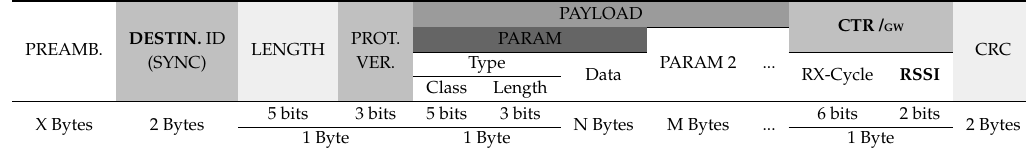
Table 3. treNch frame format for gateway-to-node transmissions (security Level